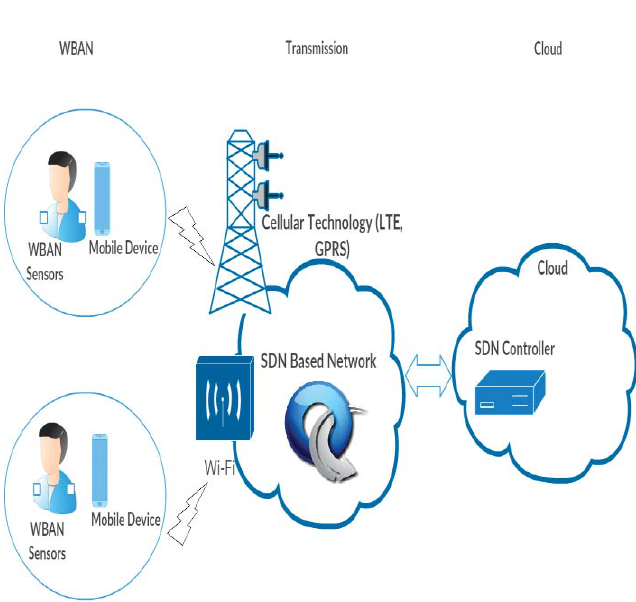
Figure 1: Conceptual architecture for WBAN with SDN